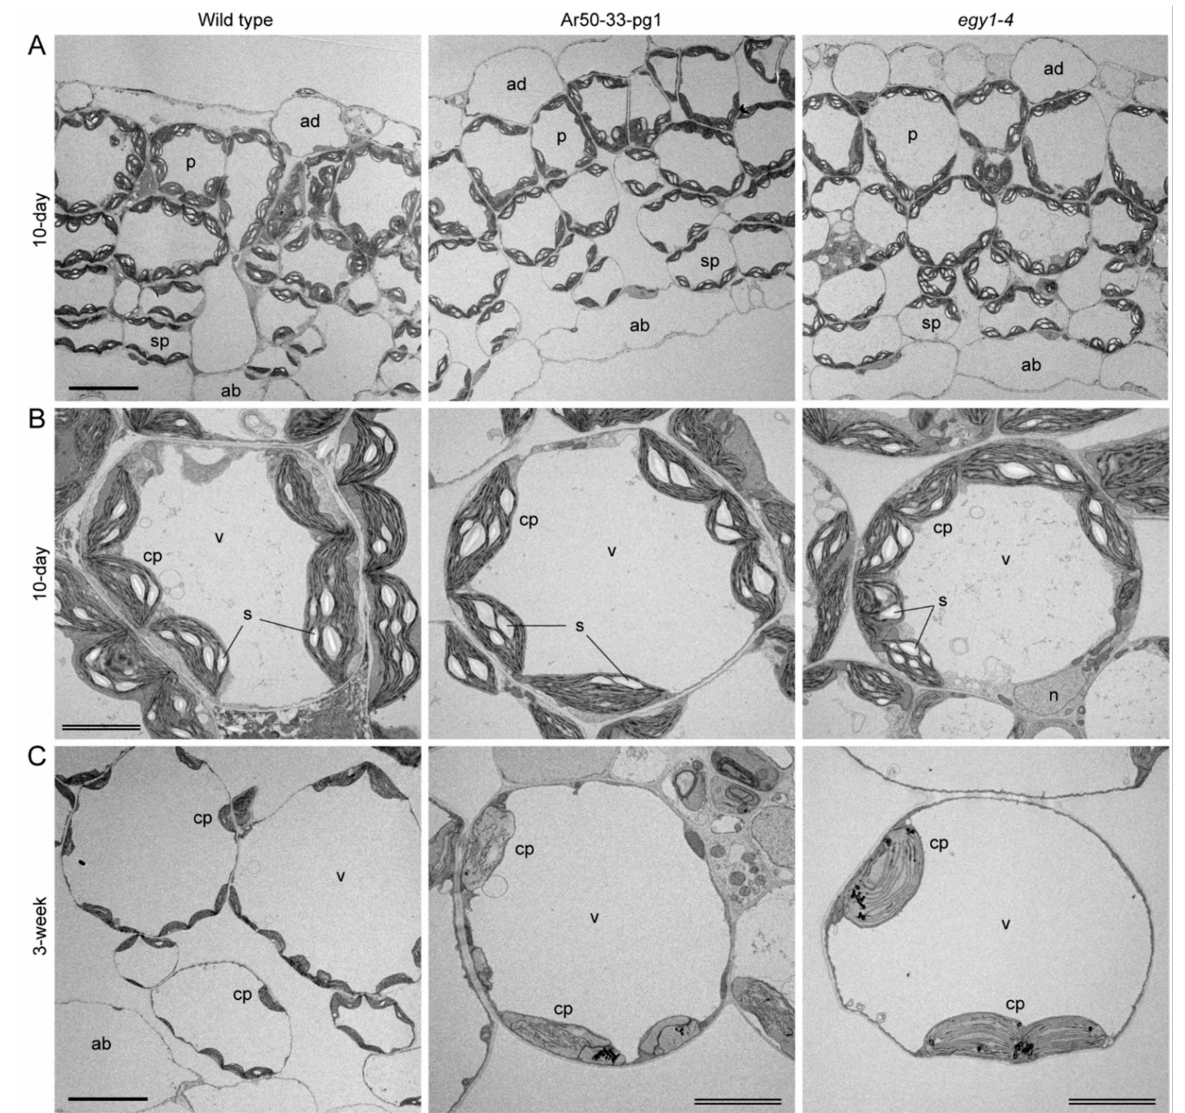
Figure 7. Ultrastructural analysis of leaf tissues and cells in wild type and mutant plants. Primary leaves of 10-day- and 3-week-old wild type, Ar50-33-pg1 and egy1-4 plants analyzed by transmission electron microscopy. ( A ) Leaf tissues of 10-day-old plants. ( B ) Mesophyll cells of 10-day-old plants. ( C ) Mesophyll cells of 3-week-old plants. Abbreviations: ab, abaxial epidermis; ad, adaxial epidermis; cp, chloroplast; p, palisade cell; s, starch grain; sp, spongy cell; v, vacuole. Bar = 20 µ m (single) and 5 µ m